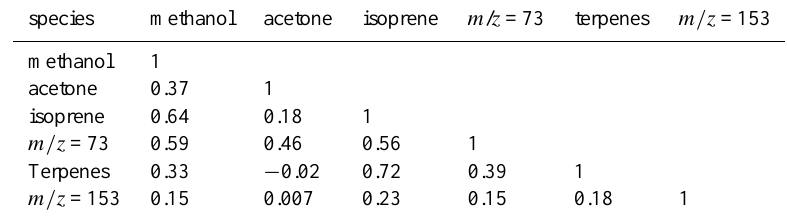
Table 4. Correlation coefficients between fluxes of individual species calculated for days 201 to 212 of